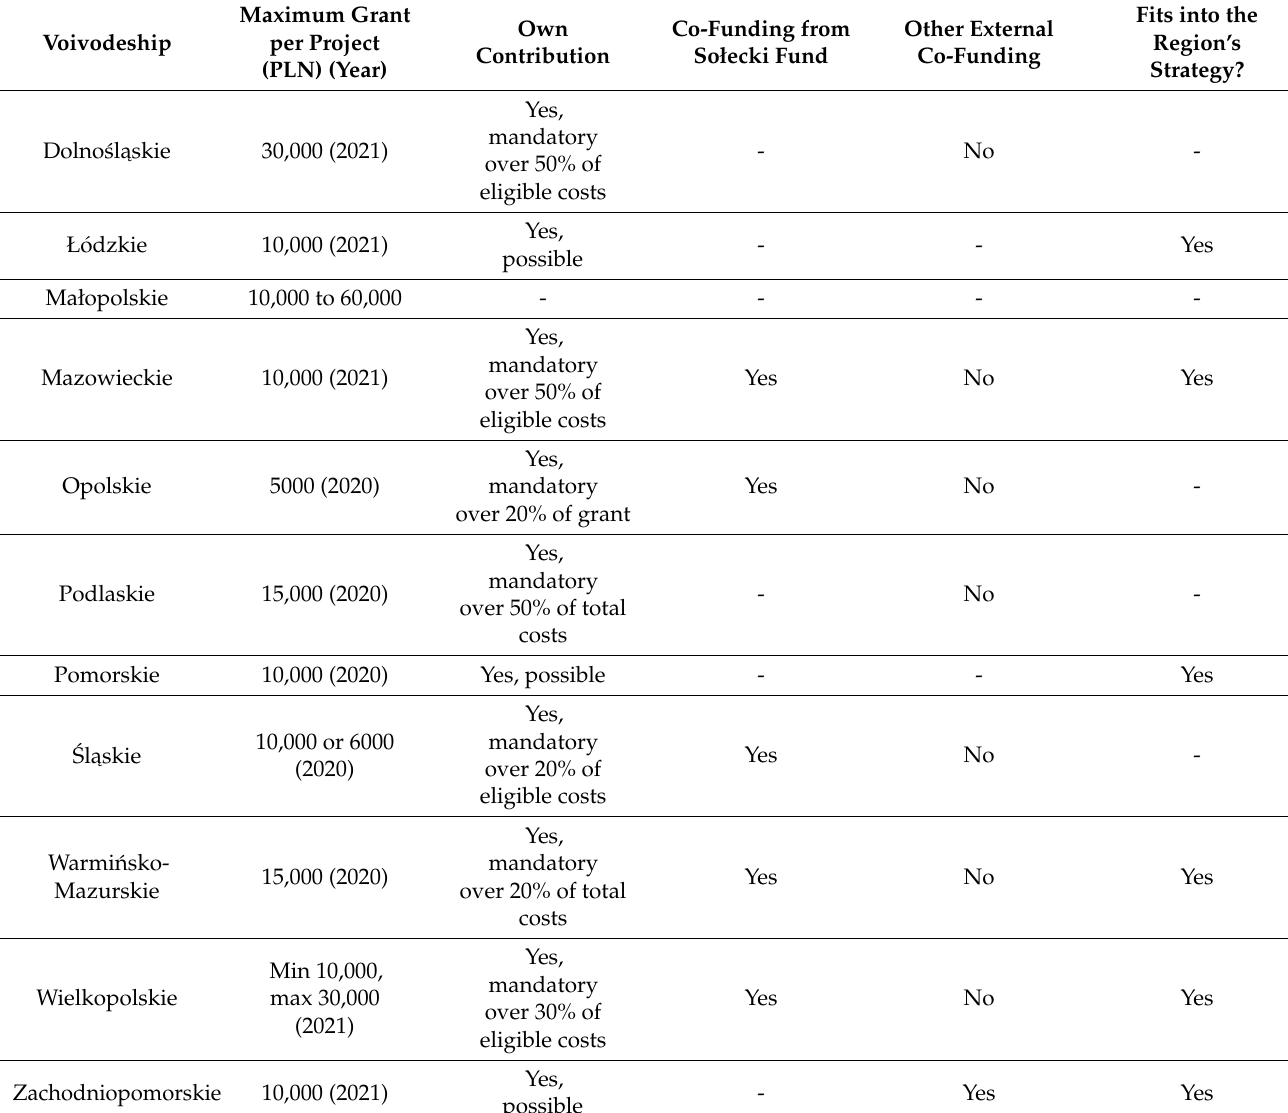
Table 2. Differences between grant